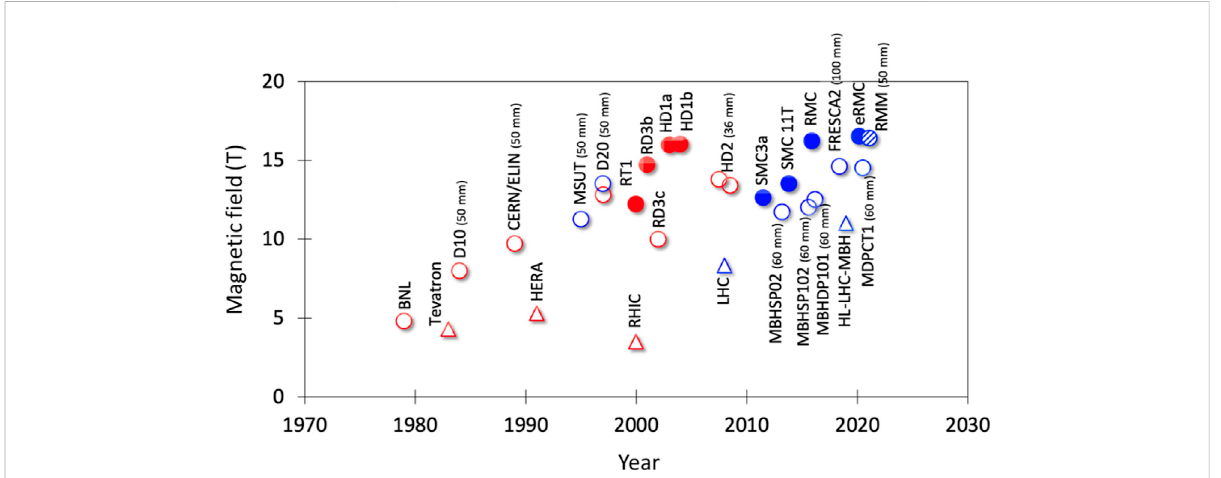
FIGURE 10 Progressionof fi eldsreached byNb 3 Sndipole magnets ofvarious con fi gurations and dimensions. Opensymbolsrepresent magnets withafree bore,solidsymbolsarefordemonstratorsbuiltwithracetracksandnofreebore.Thehatchedsymbol(RMM)isamagnetwithafreecavity.Testswere performed in liquid helium (4.2 K, red symbols) or super fl uid helium (1.9 K, blue symbols). Superconducting collider dipole magnets are shown as triangles for comparison.